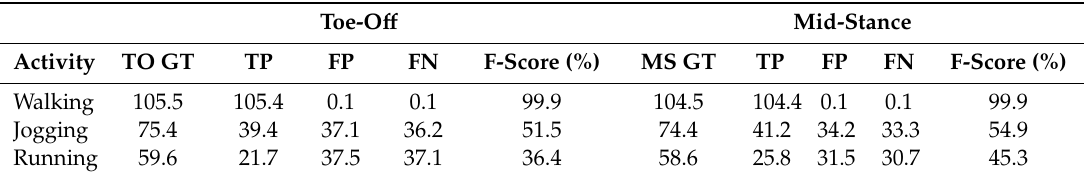
Table 2. Averaged results of TO and MS detection for the 10 participants in the Unicauca dataset using the previous TO and MS detection algorithms.